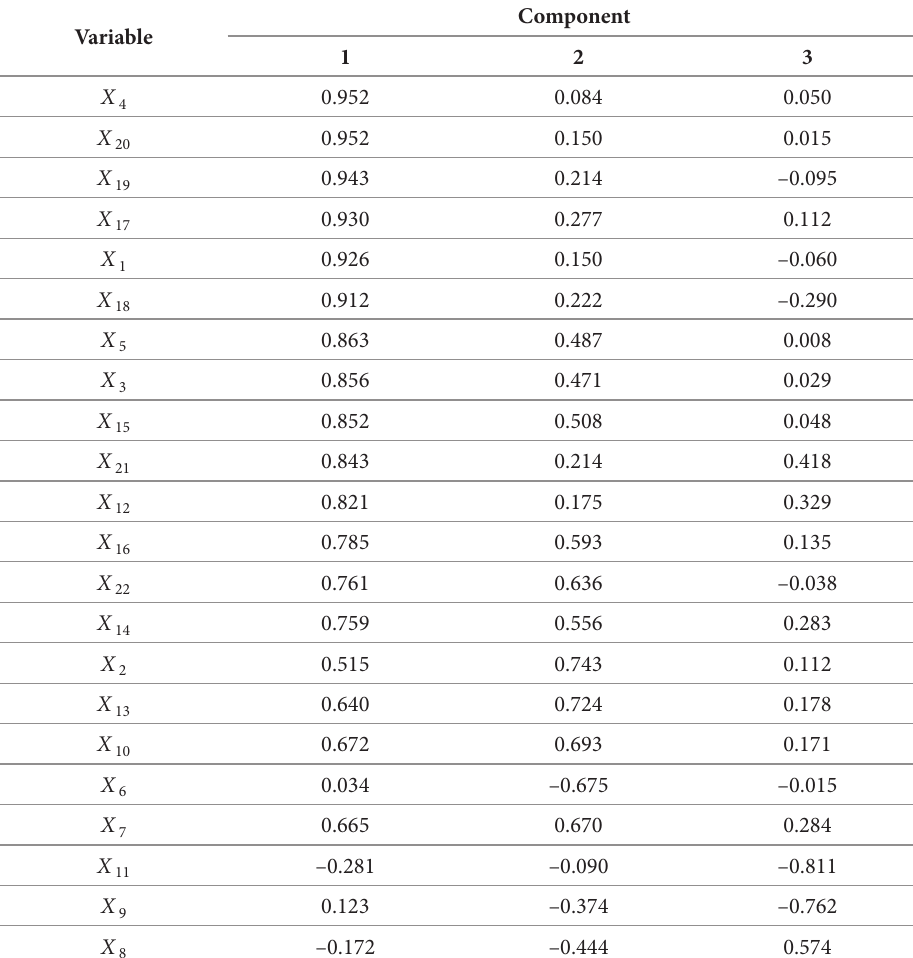
Table 4. Rotated Component Matrix a